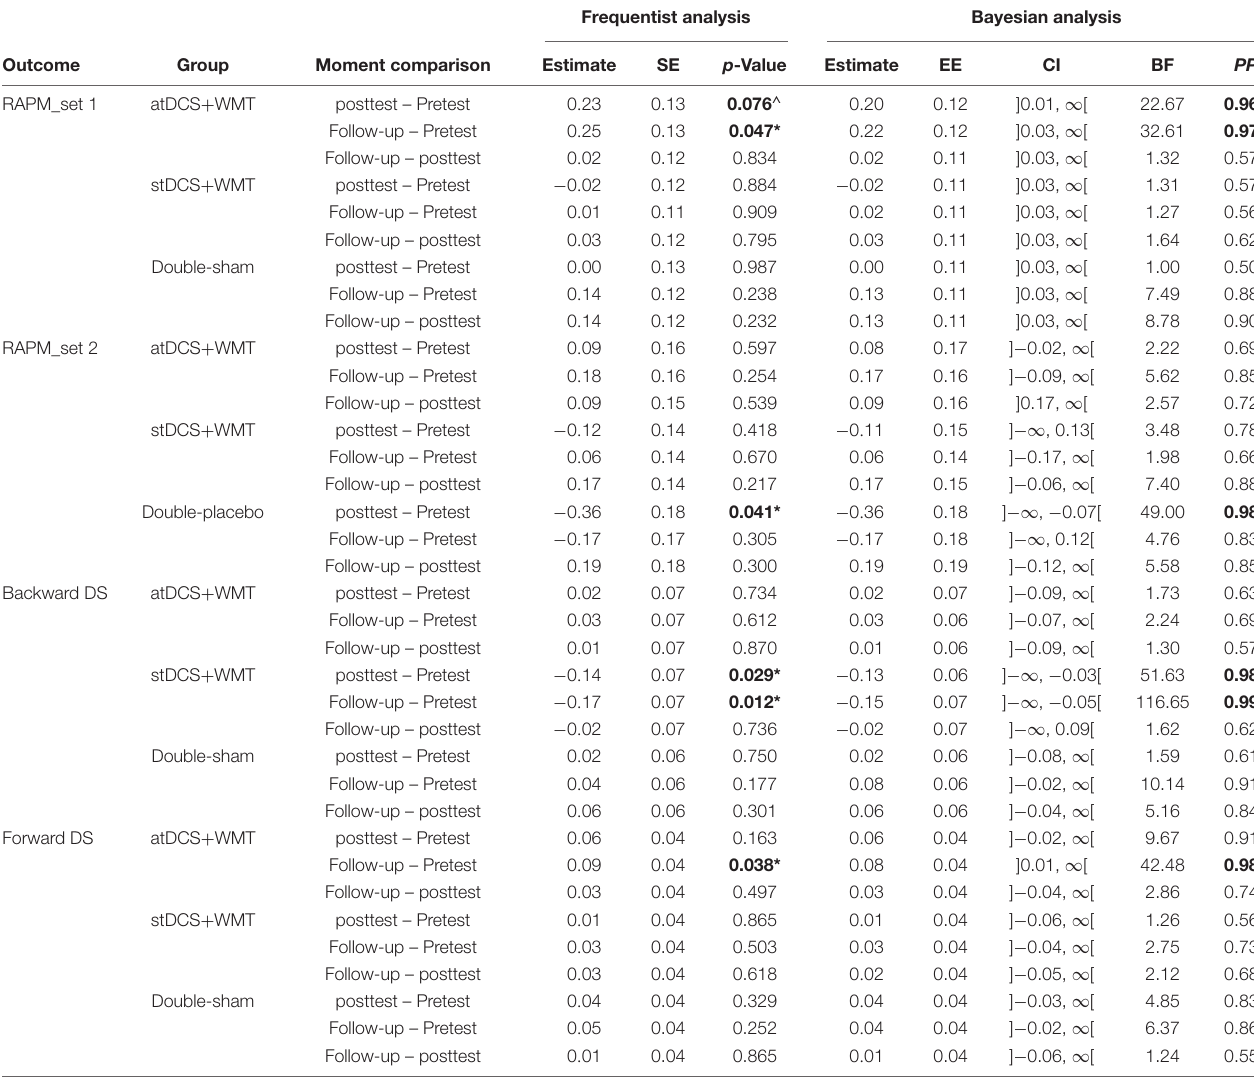
TABLE 1 | Generalized mixed-effect models result for each moment per group.